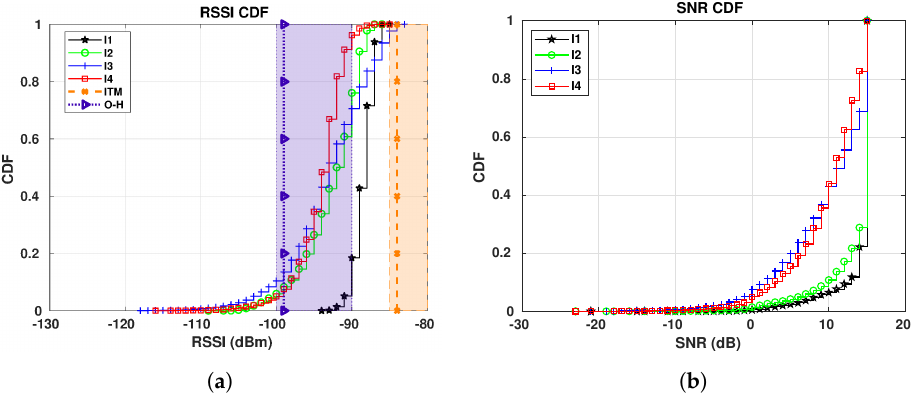
Figure 22. E5 RSSI and SNR CDFs for GW3: I1 (16/01/2019 to 07/02/2019): − 16.96 ◦ C on average; I2 (22/12/2018 to 06/01/2019): − 9.45 ◦ C on average; I3 (25/10/2018 to 04/11/20018): − 0.15 ◦ C on average; I4 (30/09/2018 to 14/10/2018): 6.56 ◦ C on average. ( a ) RSSI CDFs. ( b ) SNR